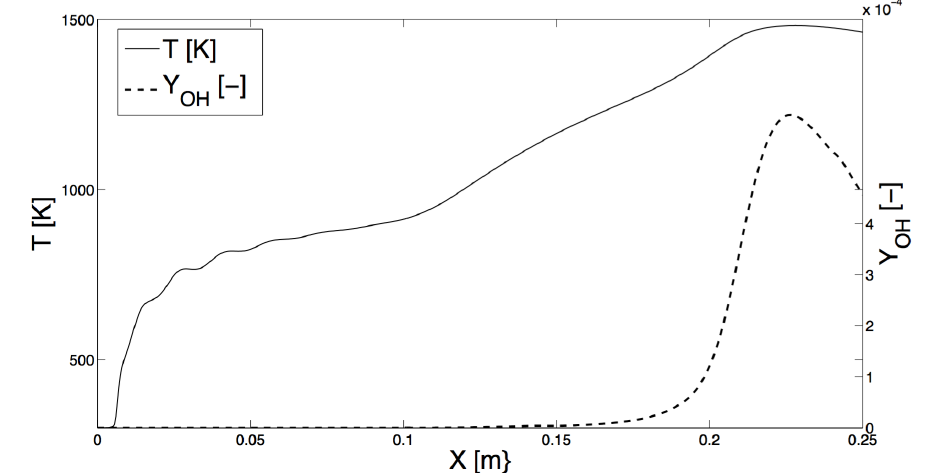
Figure 2. Temperature distribution (K) and radical OH mass fraction (-) along the axis of the combustion chamber. EDC-GRI2.11 numerical